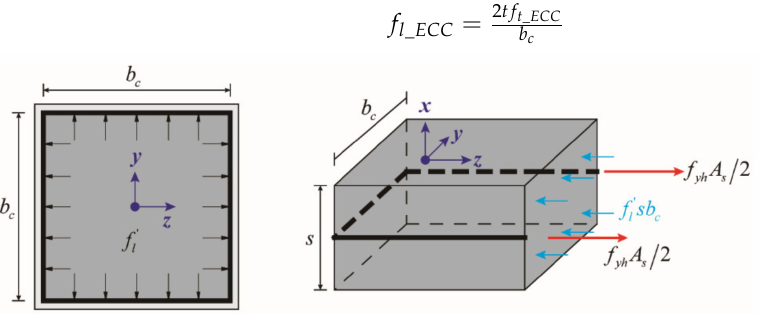
Figure 6. Forces acting on the free body of the confined concrete by ties.